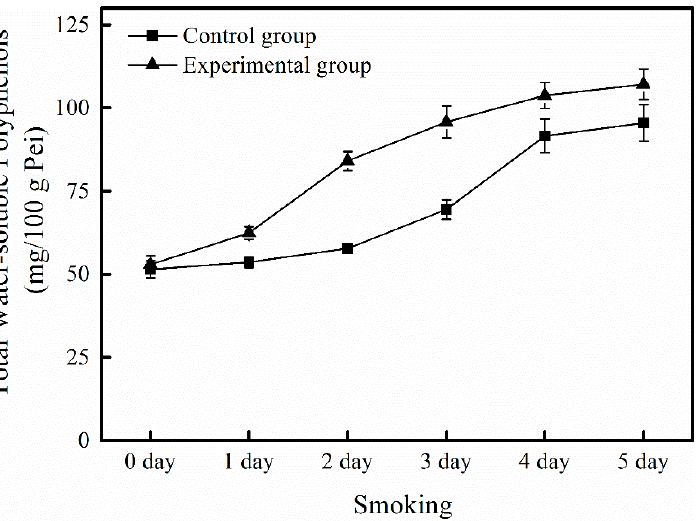
Figure 6. Effect of in situ regulation on changes in total water-soluble polyphenols content during the smoking process of Shanxi aged vinegar.